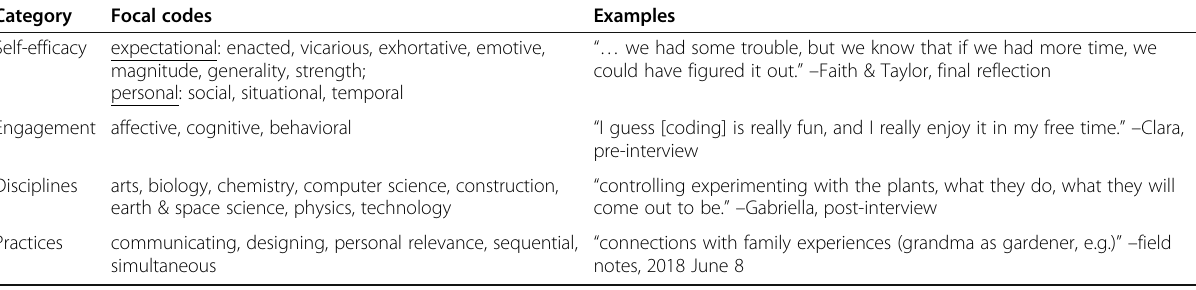
Table 5 Focal codes for final cross-case analysis